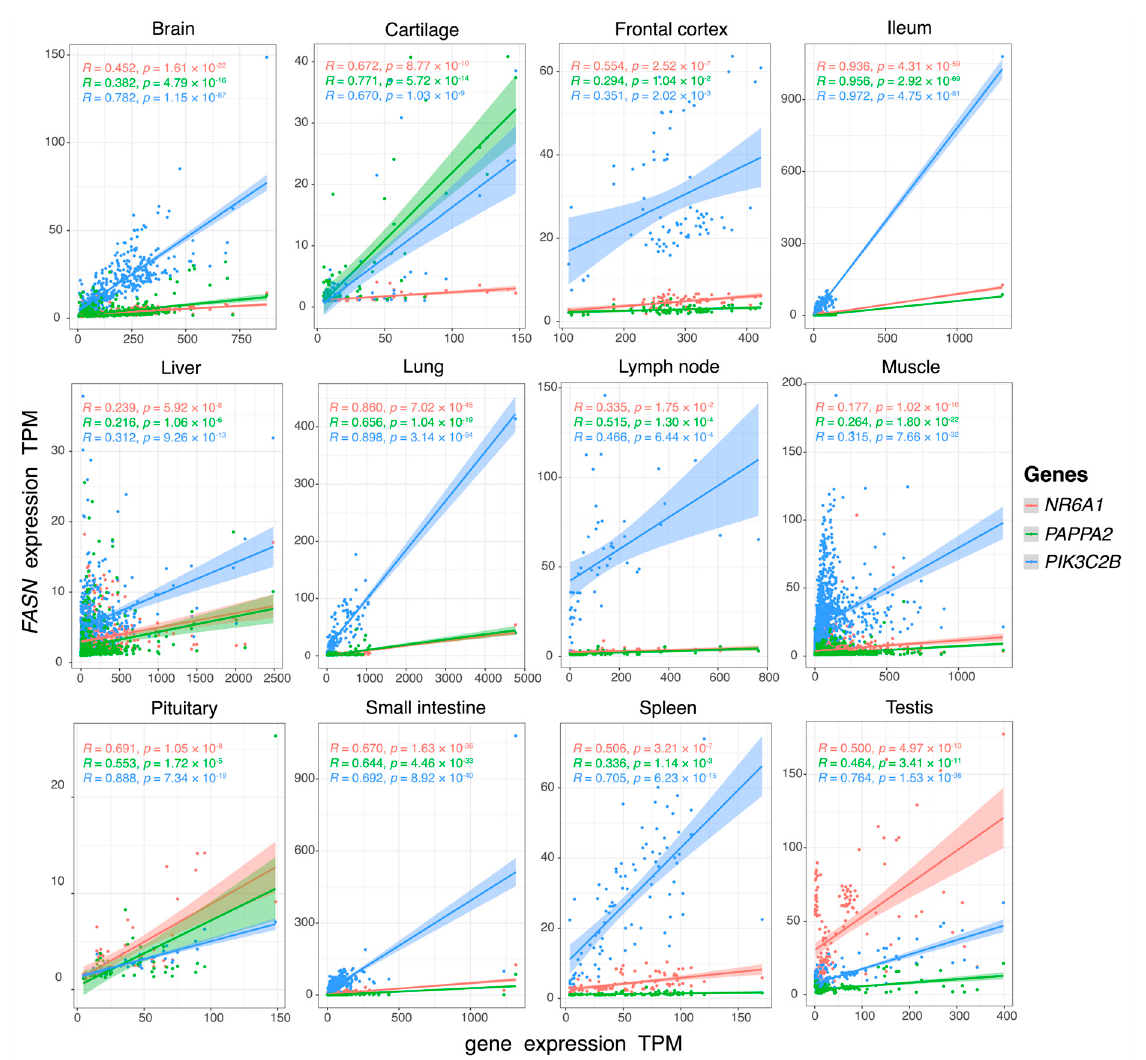
Figure 5. The correlation of gene expression between NR6A1 , PAPPA2 , PIK3C2B , and FASN across twelve pig tissues.